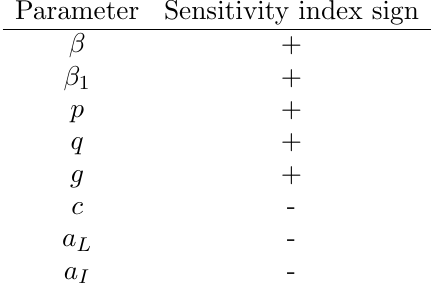
Table 1. Sensitivity indexes for rel- evant parameters of model (1). Parameter Sensitivity index sign